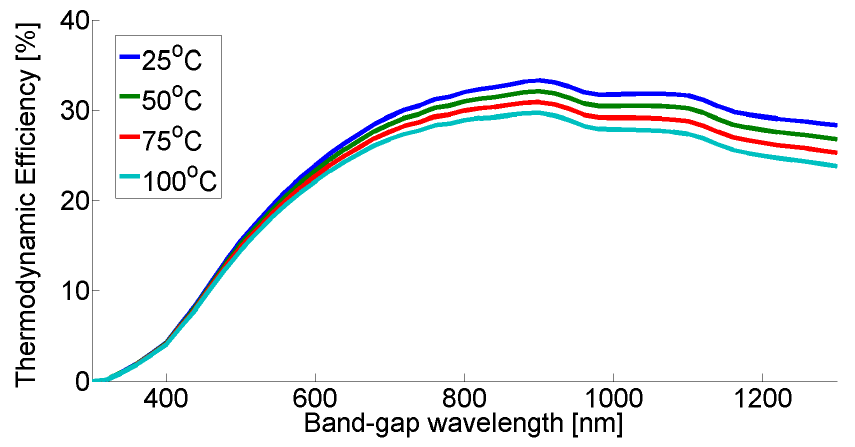
Figure 2. Efficiency curves of the Ross–Hsiao model as a function of temperature. Figure 2. E ffi ciency curves of the Ross–Hsiao model as a function of